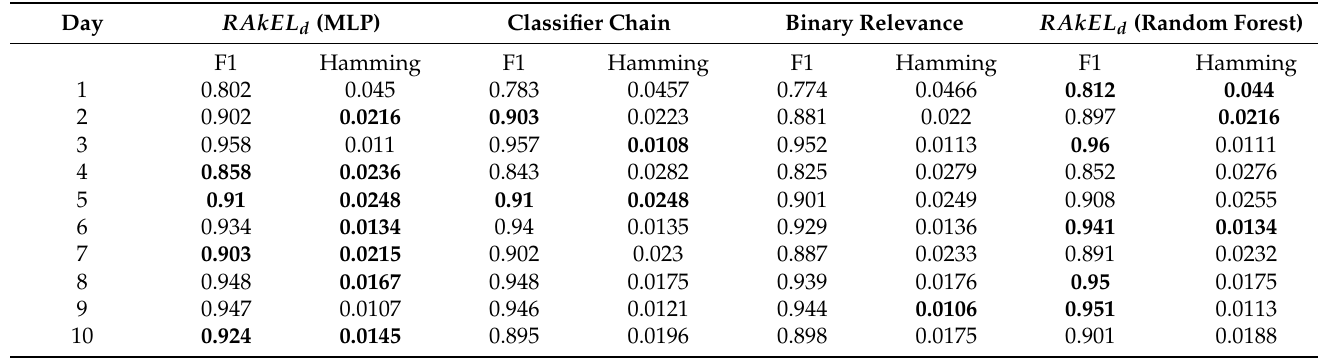
Table 9. Average F1 score and Hamming loss per day for House B. Best value per day can be seen in